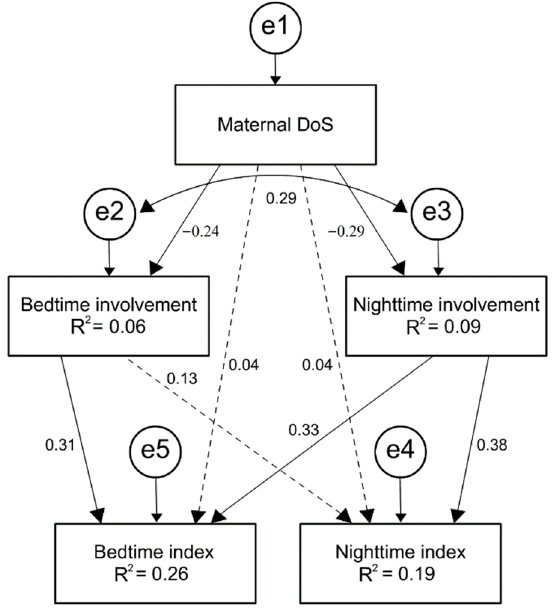
Figure 1. SEM model predicting child sleep difficulties based on mothers’ DoS and their sleep-related involvement. Continuous lines indicate statistical significance